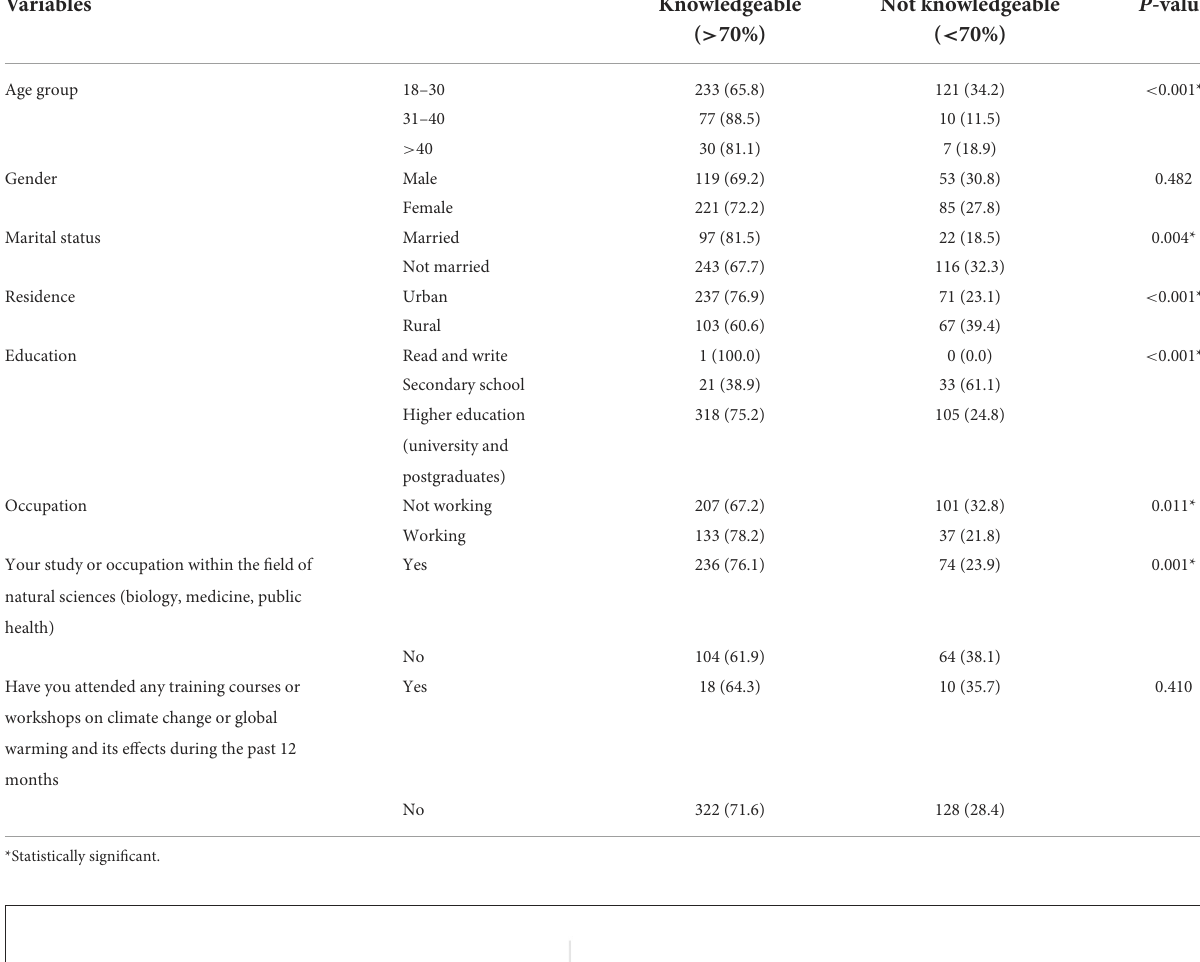
TABLE 4 Global warming/climate change level of knowledge with sociodemographic characteristics of the participants ( n = 478).